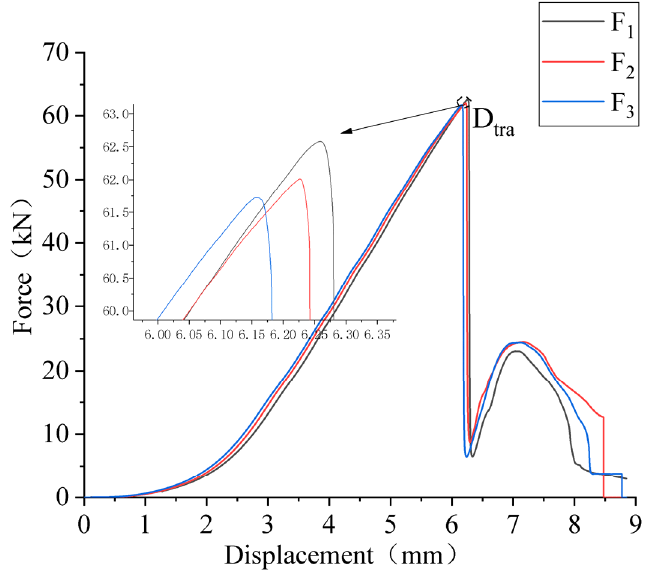
Figure 2. Same SOC cell load-displacement curve.